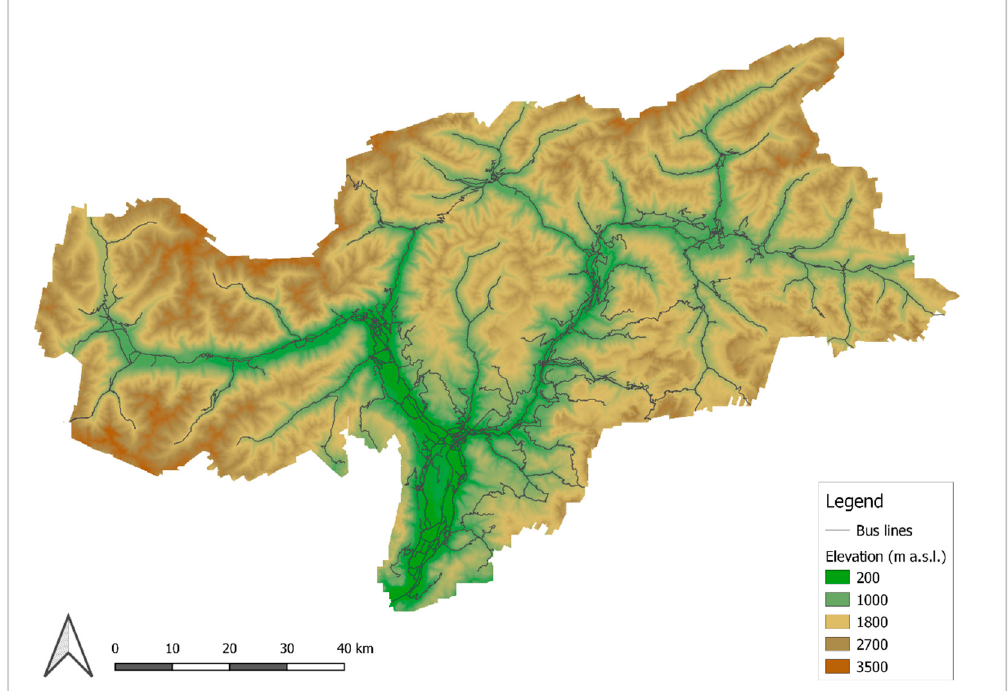
Figure 1. Bus lines analyzed in the case study of South Tyrol province, Italy.